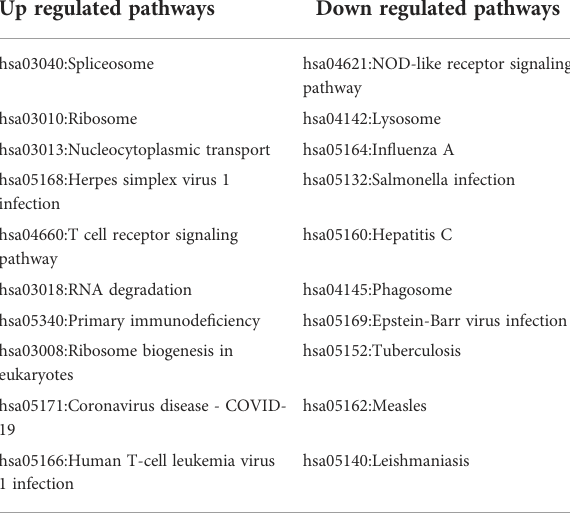
TABLE 4 List of top 10 signi fi cantly enriched human pathways in the meta-analysis. Up regulated